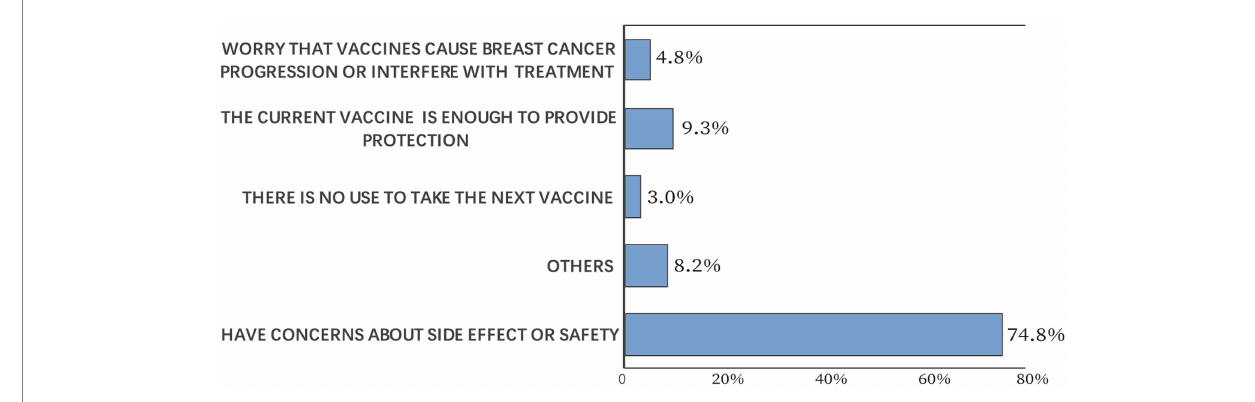
FIGURE 4 Participants’ reasons for not taking another COVID-19 vaccine